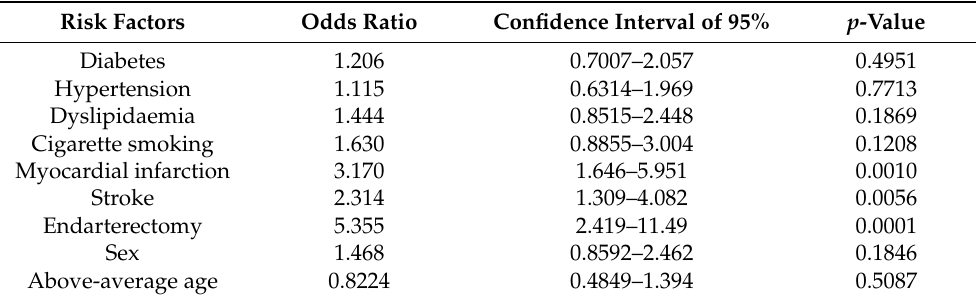
Table 4. Analysis of the correlations between the risk factors and worsening of carotid stenosis (stable and worsened patients whose aggravation level is less than 50% vs. worsened patients whose aggravation level is more than 50%).